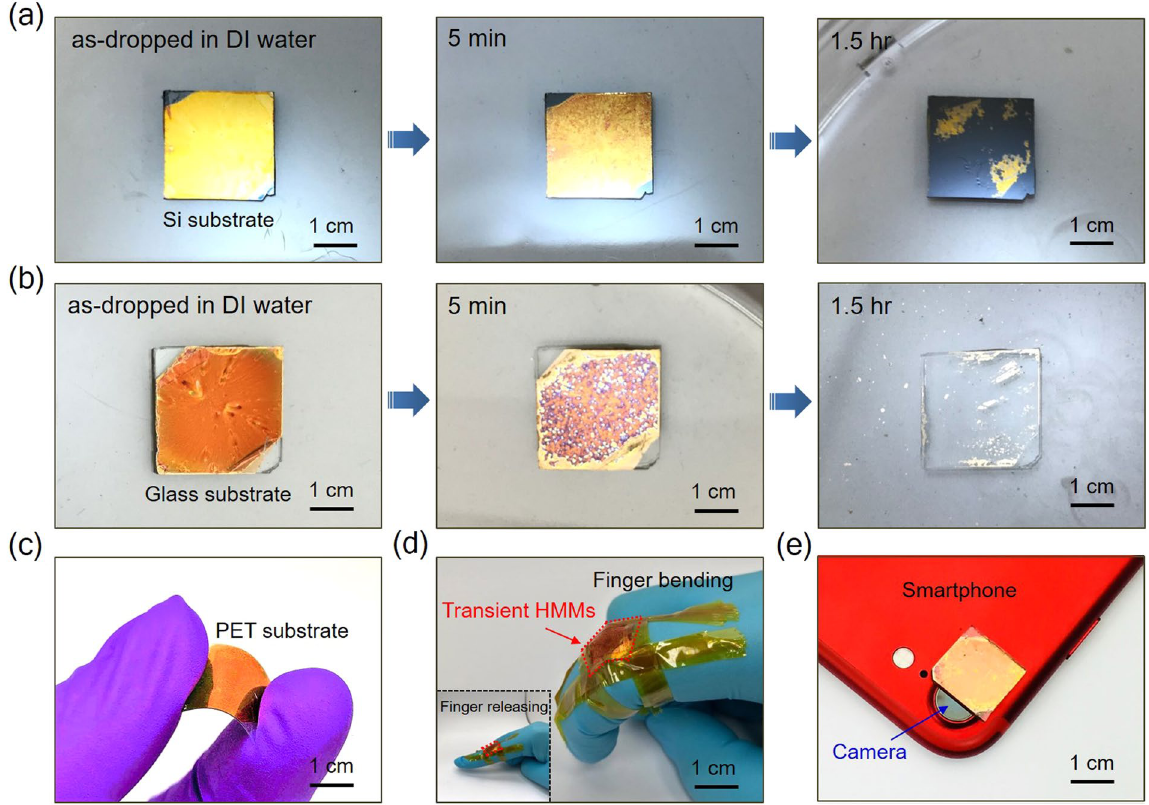
Figure 5. Demonstration of the dissolvability and the flexibility of the transient HMMs. ( a ) and ( b ) are the dissolving processes in deionized (DI) water for the HMM1 sample on Si substrate and HMM2 sample on glass substrate, respectively. ( c ) Transient HMMs on a PET substrate in a bending configuration. ( d ) Piece of a transient HMMs device was attached to a human finger in a bending gesture. Inset image is the finger in the releasing configuration. ( e ) Integration of the transient HMMs with a camera of